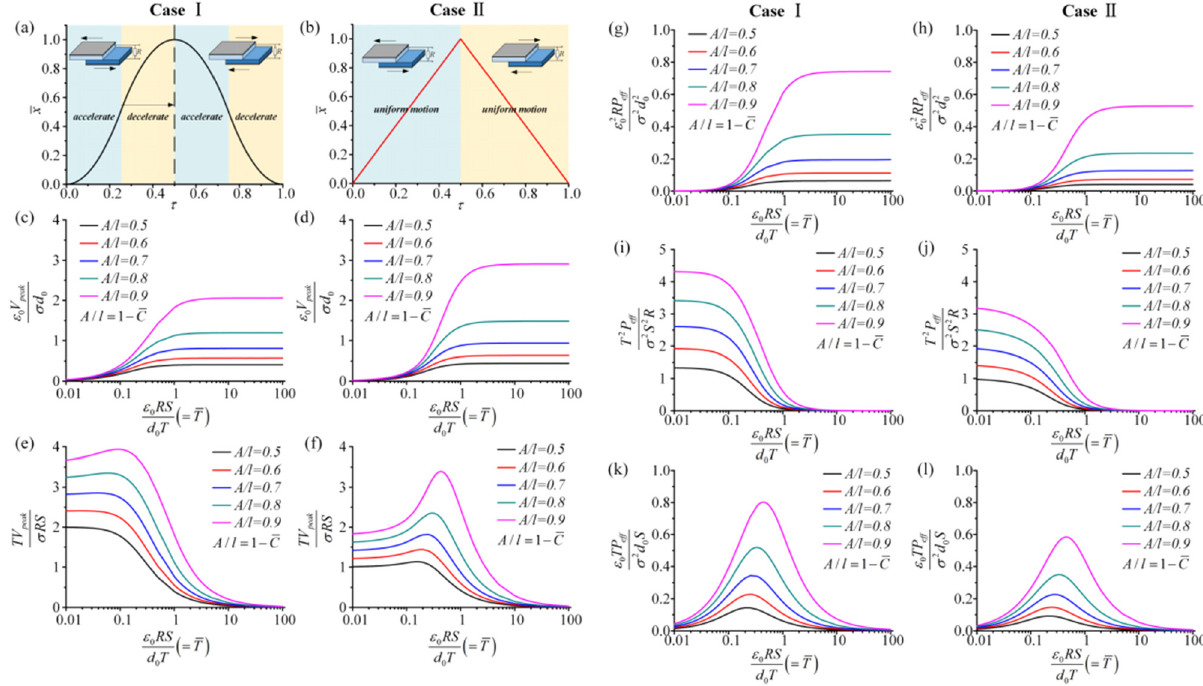
Figure 7: Scaling laws of sliding - mode TENGs for dimensionless output voltage and power in cases I and II. ( a – b ) x ¯ – τ relationship in case I and case II. ( c – d ) Scaling laws for / ε V σd 0 peak 0 in case I and case II. ( e – f ) Scaling laws for TV peak / σ RS in case I and case II. ( g – h ) Scaling laws for ε 02 RP e ff / σ 2 d 02 in case I and case II. ( i – j ) Scaling laws for T 2 P